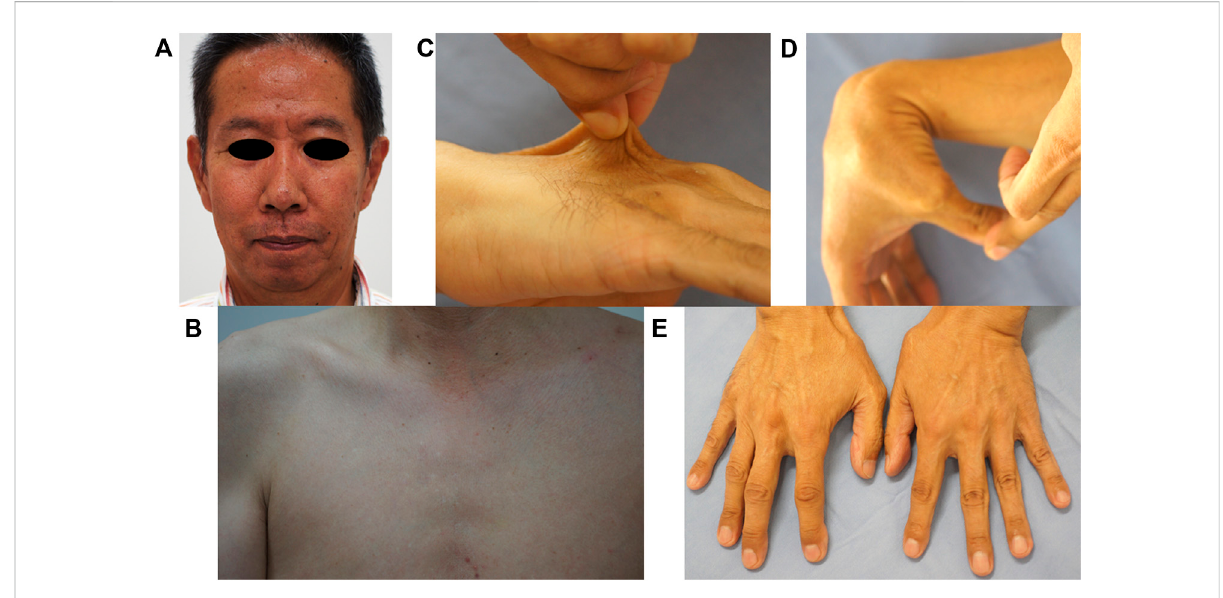
FIGURE 1 Clinical fi ndings. No remarkable fi ndings in terms of vEDS facial features (A) , no permeability of subcutaneous blood vessels (B) , and no skin hyperextension (C) were observed. Mild small joint hypermobility (D) and acrogeria were observed (E)